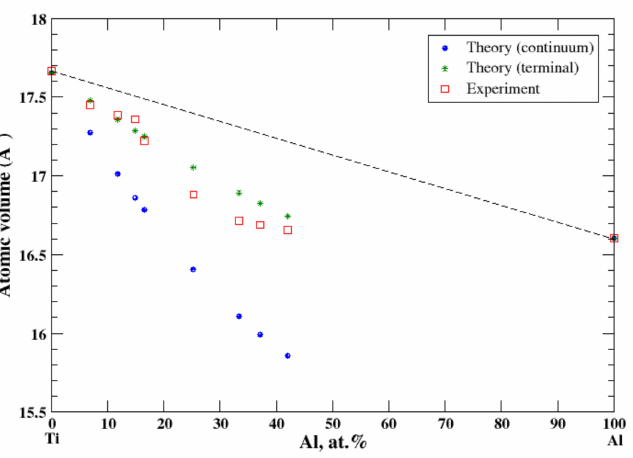
Figure 5. Atomic volume vs. concentration for Al-Ti alloy system. The experimental data are from Ref. [16] (p.